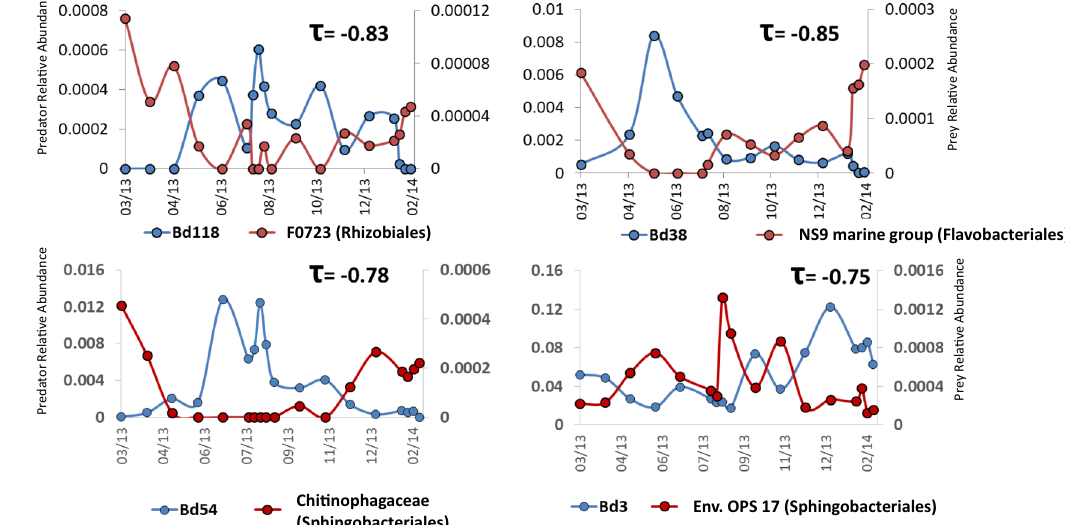
Fig. 4 BALO-prey dynamics. Negative correlations (Kendall τ > -0.7, p < 0.05) of predators with potential prey identi fi ed at the family level (the order is in